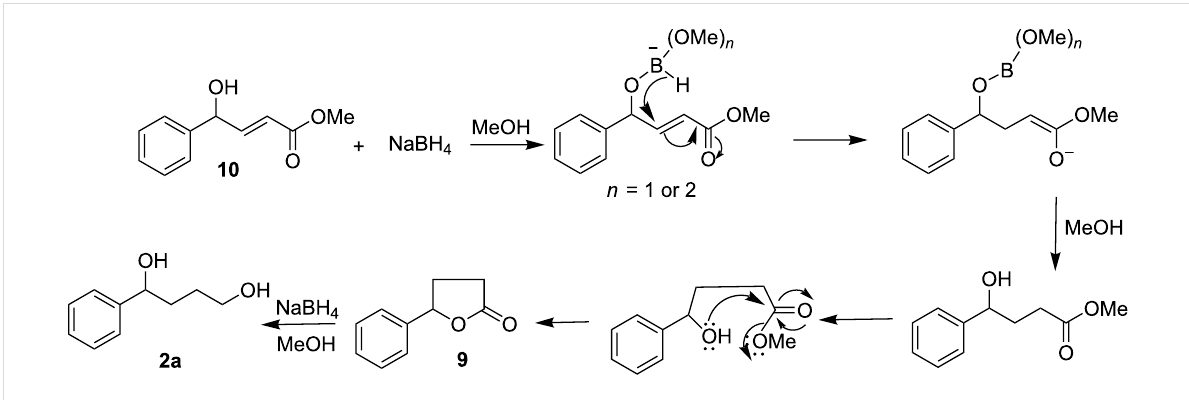
Figure 1: Mechanistic rationale for diol formation during the reduction of a γ -aryl- α , β -unsaturated- γ -ketoester with methanolic NaBH 4 .